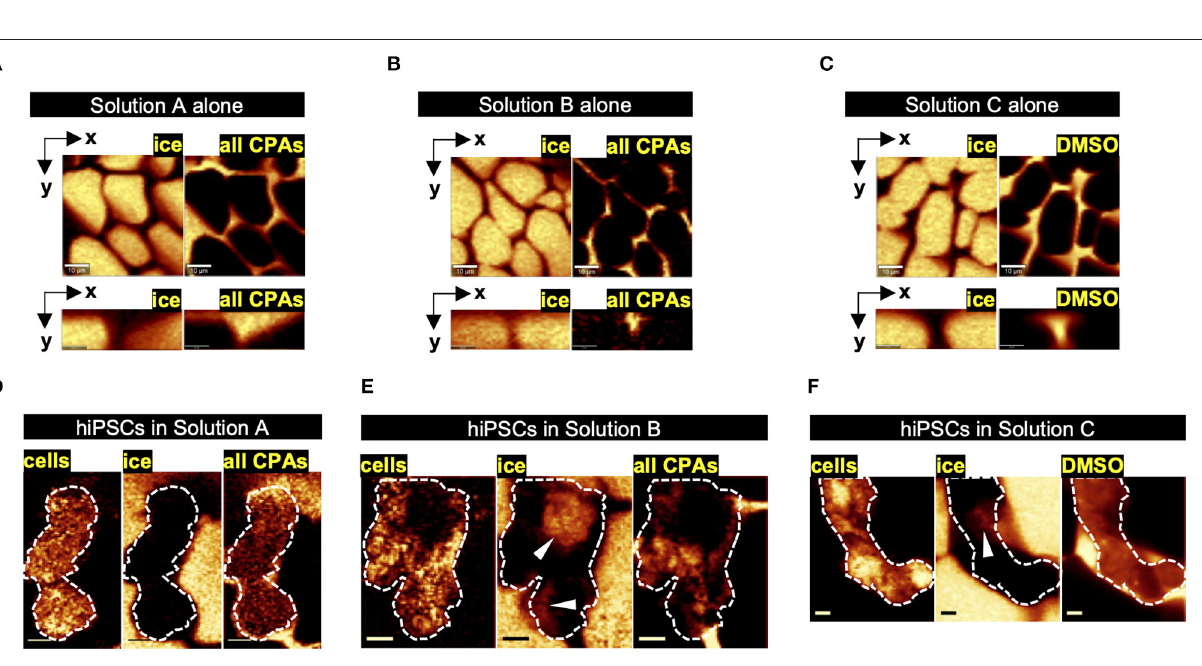
FIGURE 4 | Raman heat maps representative of freezing responses in optimized dimethyl sulfoxide (DMSO)-free vs. non-optimized DMSO-free vs. optimized DMSO solutions. (A–C) Raman heat maps of ice crystals separated by non-frozen channels of the respective cryoprotective agent (CPA) solution at − 50 ◦ C shown in lateral plane (scale bar: 10 µ m) and axial plane (scale bar: 3 µ m). (D–F) Raman heat maps of ice formation and CPA distribution in cell aggregate frozen in the respective solution at − 50 ◦ C (scale bar: 5 µ m), with the cell aggregate outlined (white dash) and intracellular ice marked (white